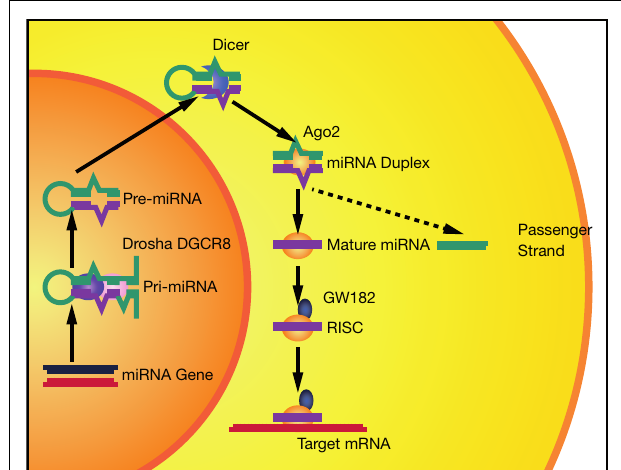
FIGURE 1 |The canonical miRNA biogenesis pathway. miRNAs are produced from long Pol II transcripts (pri-miRNA). A nuclear complex containing Drosha (purple oval) and DGCR8 (pink oval) cleaves the primary transcript and generates a precursor miRNA (pre-miRNA). After nuclear export, pre-miRNA is further processed by Dicer (blue croissant).Then, Ago2 (yellow oval) binds to the complex formed by miRNA duplex and Dicer. Ago2 induces Dicer dissociation and the release of the passenger strand from the complex. Finally, other proteins, such as GW182 (dark blue), associate with Ago2 and form a RISC complex that recognizes and then silences (by mRNA degradation and/or translation inhibition) a target